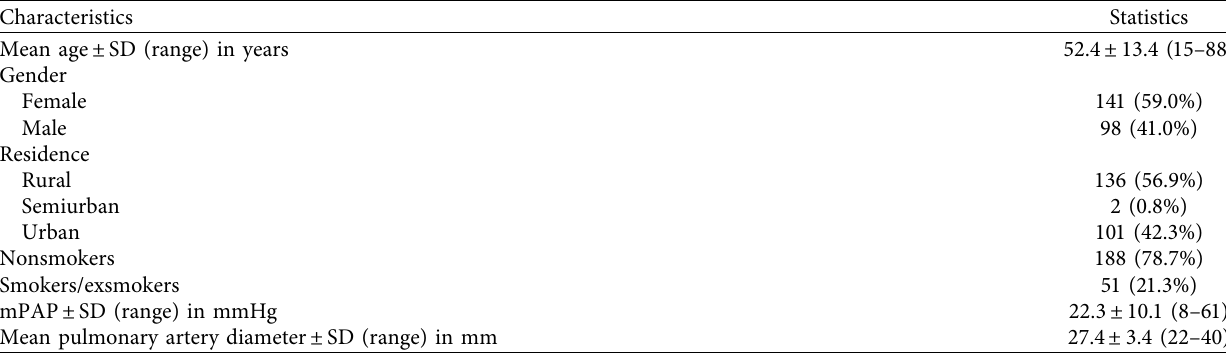
Table 1: Baseline characteristics of the study population (n � 239).